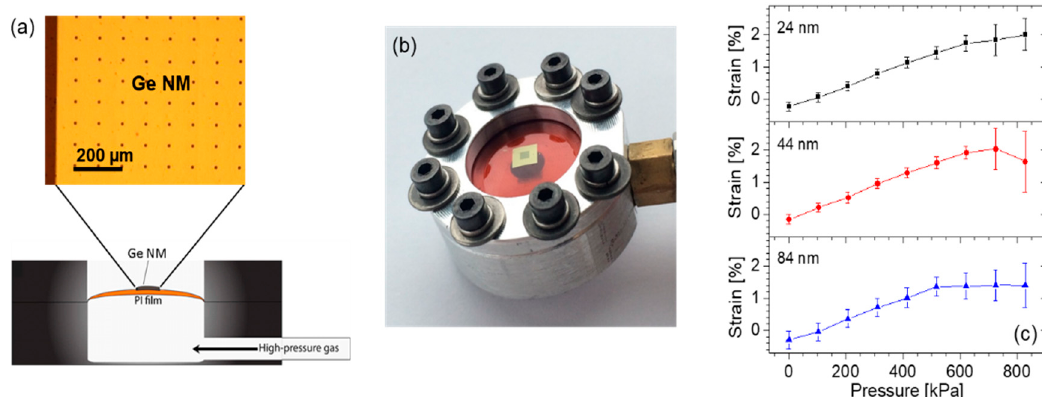
Figure 3. Mechanically stressed Ge NMs. ( a ) Schematic illustration of the experimental setup used to introduce biaxial tensile strain in Ge NMs. A top-view optical micrograph of a NM bonded onto a PI film is also shown. The periodic black dots are etchant access holes, used to facilitate the Ge NM release from its GOI substrate. Reproduced with permission from [23]. American Chemical Society, 2014; ( b ) Photograph of the sample mount under an applied gas pressure of 520 kPa. The Ge NM (here containing an overlaying pillar array, as described in Section 2 below) is visible near the center of the PI film. Reproduced with permission from [28]. AIP Publishing LLC, 2016; ( c ) Strain/stress curves measured by Raman spectroscopy on Ge NMs with three different thicknesses. Reproduced